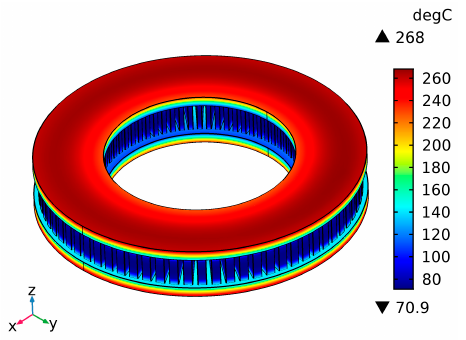
Figure 10. Temperature cloud at 41 s of braking for ventilated discs.